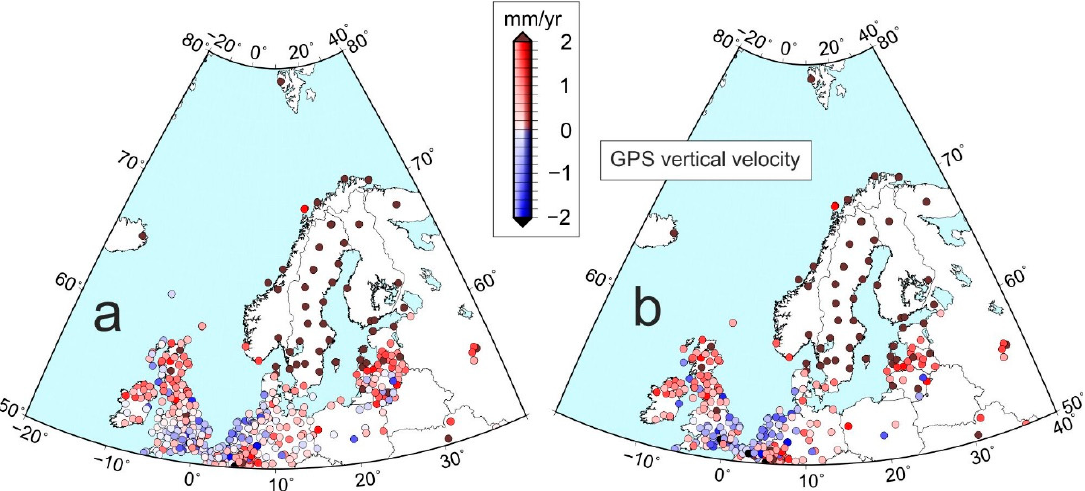
Figure 4. ( a ) The GPS-derived vertical rates, estimated for all European GPS stations employed in this research: 469 stations are presented. ( b ) The statistically significant GPS-derived vertical rates: